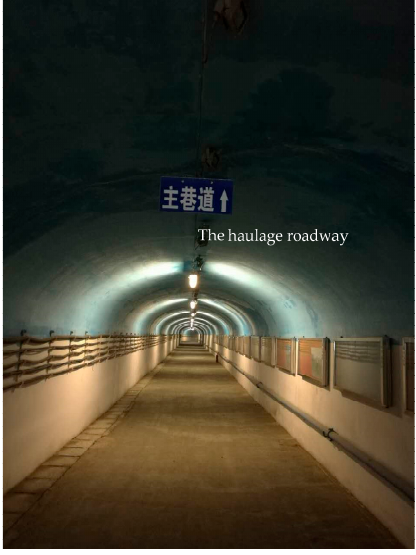
Figure 1. The haulage roadway.